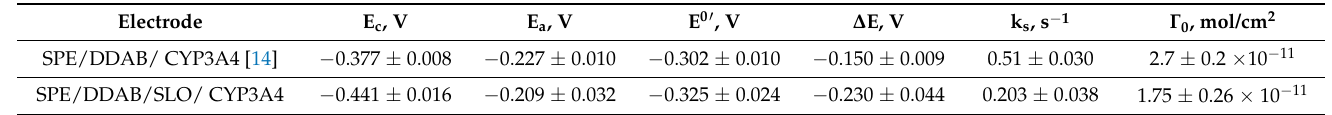
Table 1. Electroanalytical parameters of CYP3A4 immobilized on SPE/DDAB and SPE/DDAB/SLO under anaerobic